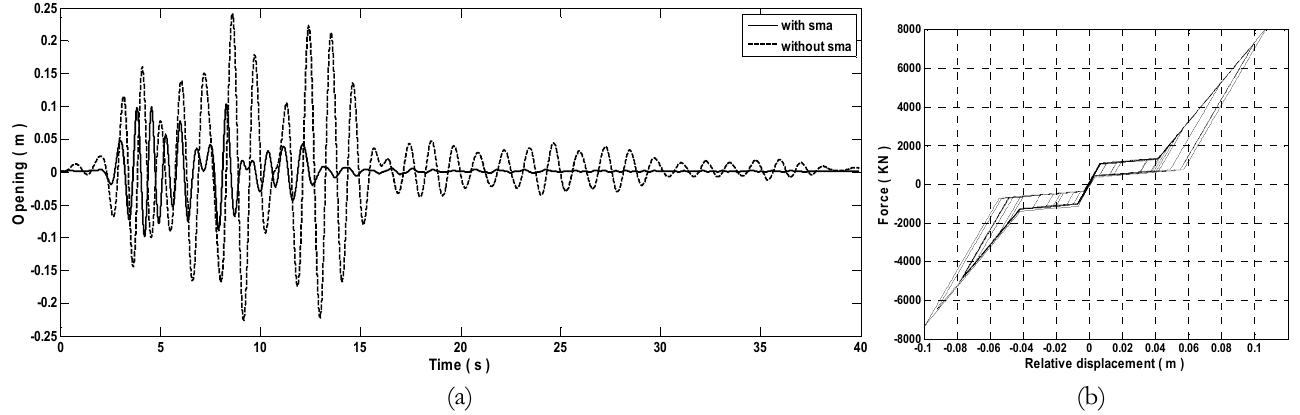
Figure 7: SMA between two adjacent frames of a bridge, (a) Comparing between the time histories of the hinge–opening when using SMA and as–built bridge under the scaled 1989 Loma; (b) Load–deformation relationship of SMA considered in the analysis with period ratio ( ρ = 0.8).